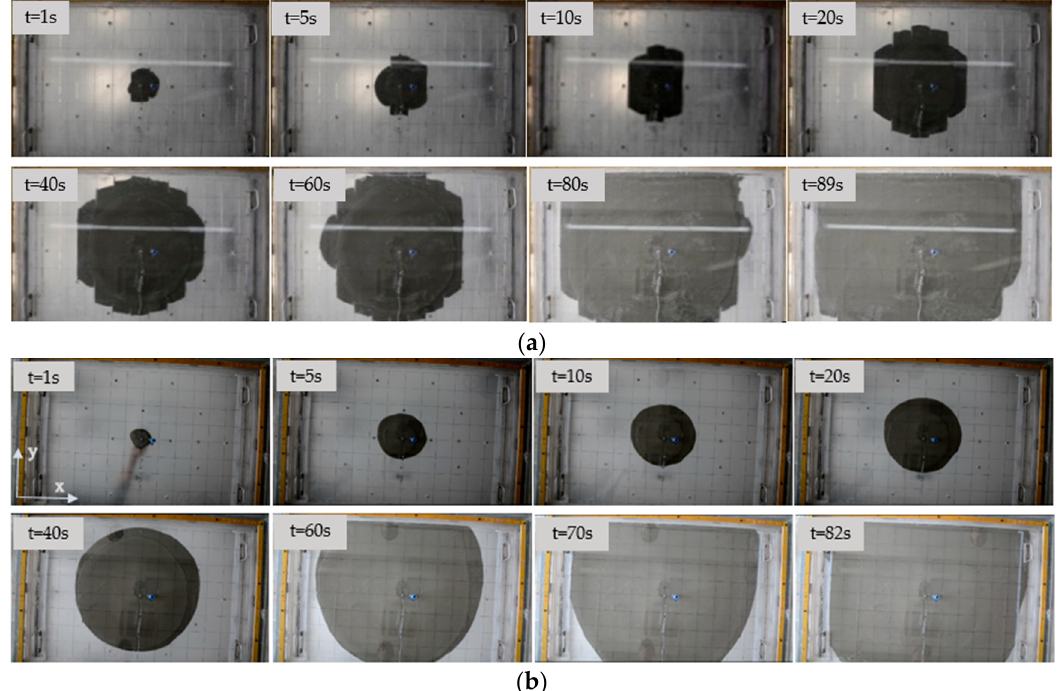
Figure 11. Actual grouting diffusion process in different fractures. ( a ) Actual grouting diffusion process in the rough fracture; ( b ) Actual grouting diffusion process in the smooth fractures.